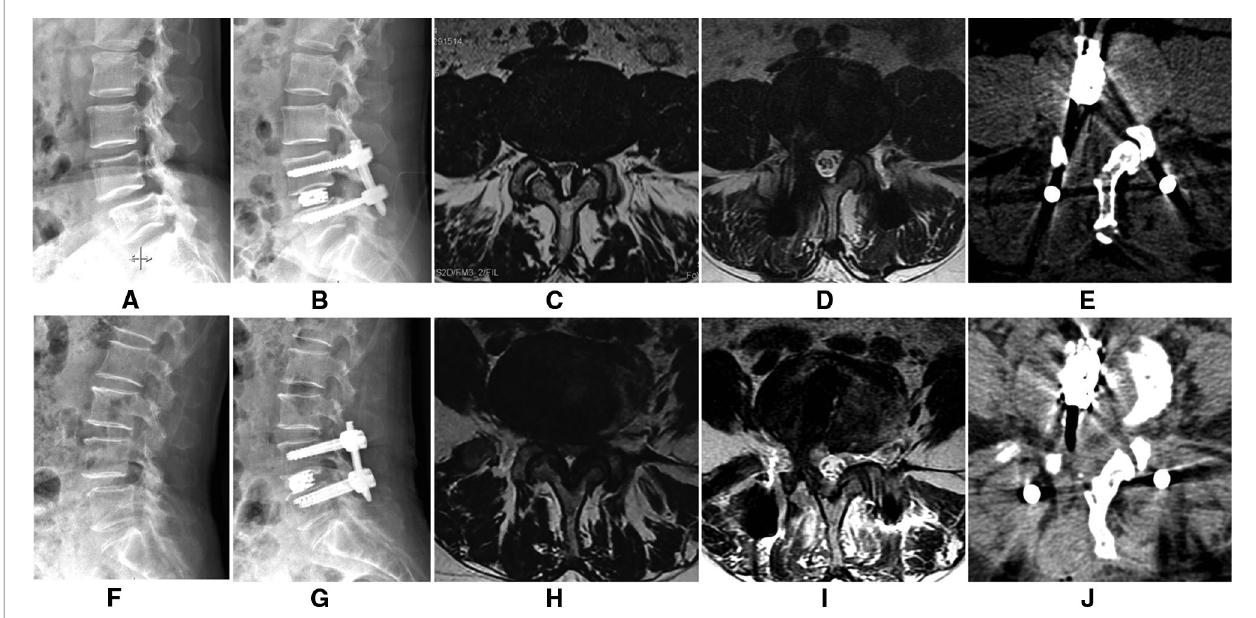
FIGURE 4 | The lateral X-Ray showing L4 spondylolisthesis ( A ), and it was complete reduction after surgery ( B ). A cross-sectional MRI image ( C ) showing lumbar spinal stenosis; the cross-sectional area of the spinal canal signi fi cantly improved after surgery ( D ). A cross-sectional CT image ( E ) showing that a part of the lamina, the articular process, and the base of the spinous process are excised to enlarge the spinal canal. The other patient is shown in ( F – J